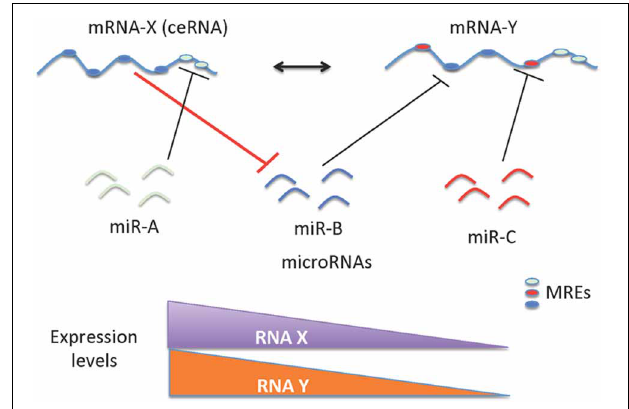
FIGURE 1 | Schematic representation of ceRNAs mediated gene regulation. The regulation of miRNAs and mRNAs are mutual; as a consequence, levels of mRNA(s) containing relevant MREs could affect the levels and activity of another mRNA. The cross talk between mRNAs mediated by the MREs depends on the number and frequency of specific type of MREs. This cross talk is significantly influenced by the number and frequency of relevant MREs in the transcriptome of a given cell. The ceRNA-miRNA-mRNA cross talk maintains the overall activity and functional balance of gene networks in a cell. The ceRNA mediated regulation of mRNA-Y is illustrated here. mRNA-Y is a functional target of miR-B. However, the expression levels of mRNA-X that contains MREs for miRNA-B can act like a sponge to sequester the effect of miR-B on mRNA-Y (indicated with bold red line). Hence a decrease in expression levels of mRNA-X can also decrease the levels of